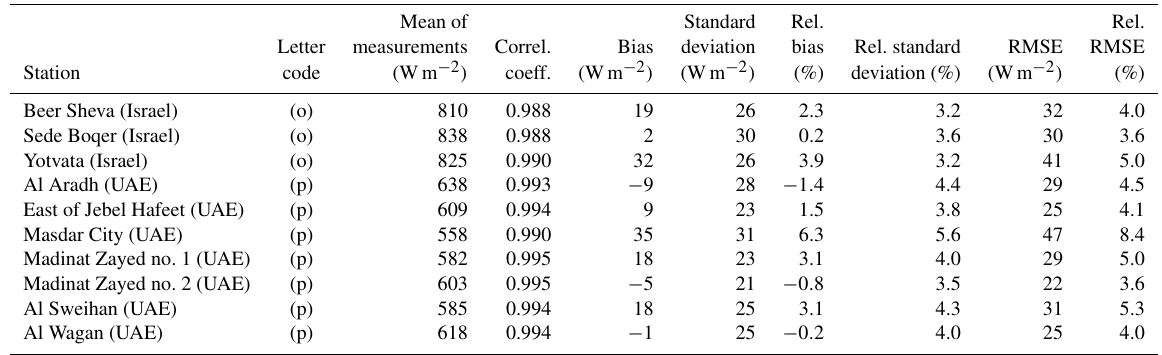
Table B2. Results from previous works at summarization 10min. Means of the measurements, correlation coefficients, bias, standard devia- tions, RMSE, and their values relative to the mean of the measurements for G .